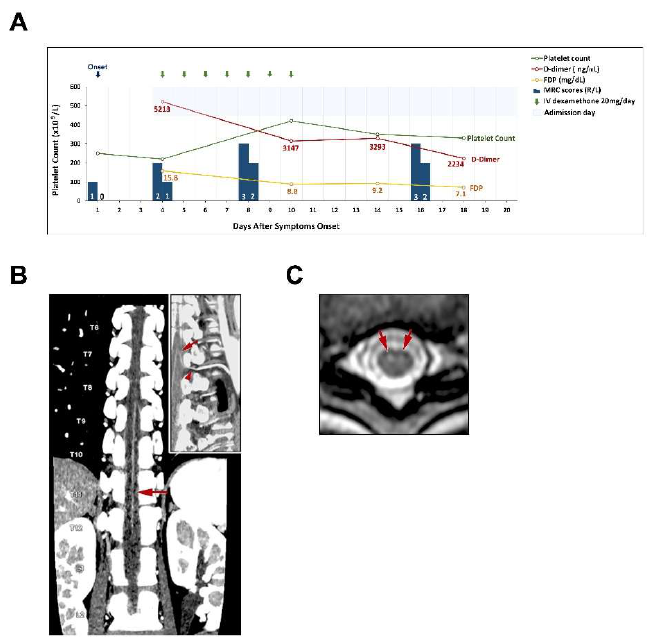
Figure 1. Clinical course and spinal cord imaging in this case. ( A ). Summary of clinical events and laboratory studies are presented. ( B ). Maximum intensity projection reconstruction of a coronal CTA image reveals tandem narrowing of the Adamkiewicz artery, more severe at the T10-11 level (arrow); the insert image is a curved multiplanar reformatted image that shows a single Adamkiewicz artery (arrow) with optimal continuity around the pedicle of the vertebral arch (arrowhead) at the left T9-10 lumbar artery and aorta. ( C ). T2-weighted axial image shows focal edema in the central cord gray matter at the T9-11 levels with greater involvement of the ventral horns (owl’s eyes sign, arrows). Table 1. Results from the selected laboratory data in our case and review of the literature. Our Case (Reference Study, Units Dunn DW et al. Case Soda T et al. Case Value)